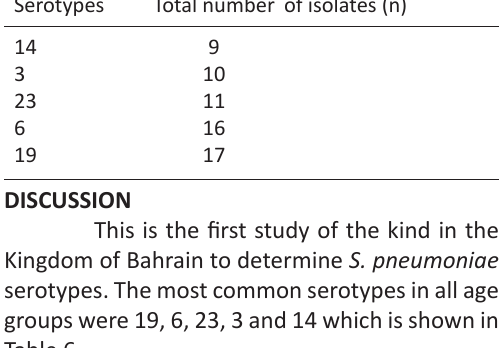
Table 6. Common serotypes in all age groups